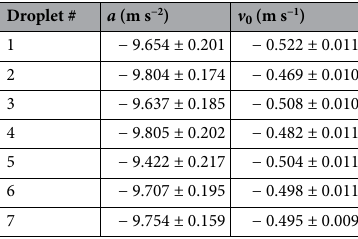
Table 1. Results of second-order polynomial curve fit for experimental results in Fig. 4d based on the constant 1 at 2 + v 0 t + z 0 . Results are given with 95% confident interval bounds. z 0 = 0.026 acceleration model z ( t ) = 2 in all